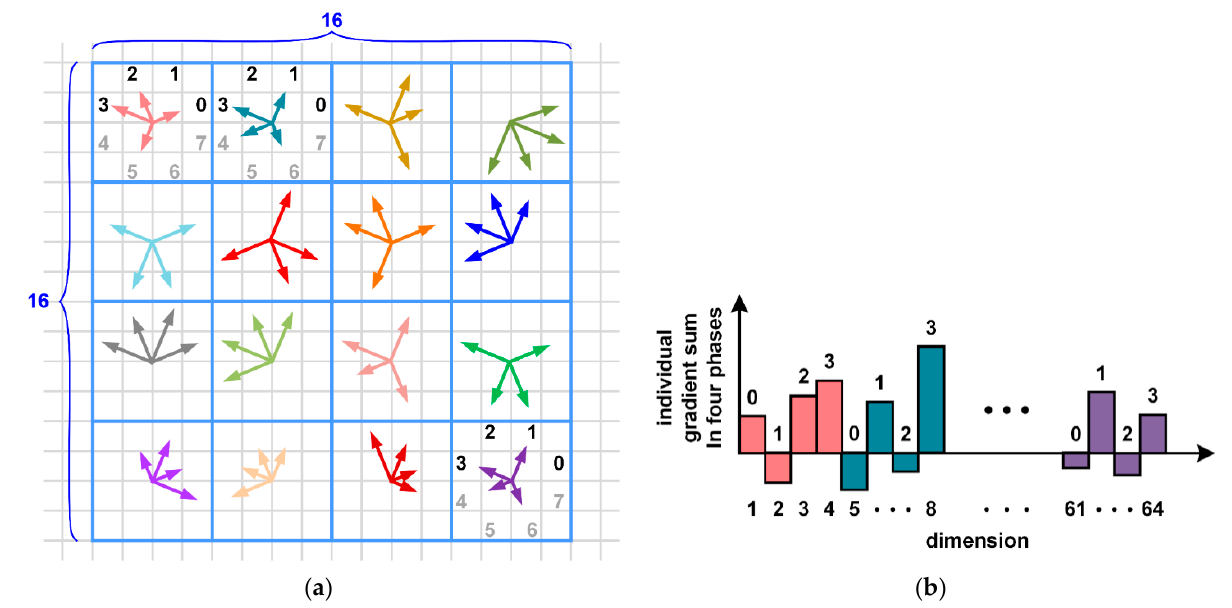
Figure 8. ( a ) Sixteen 4 × 4 partitions in a 16 × 16 mask for the feature descriptor and ( b ) the corresponding gradient sum in each 4 × 4 partitions.